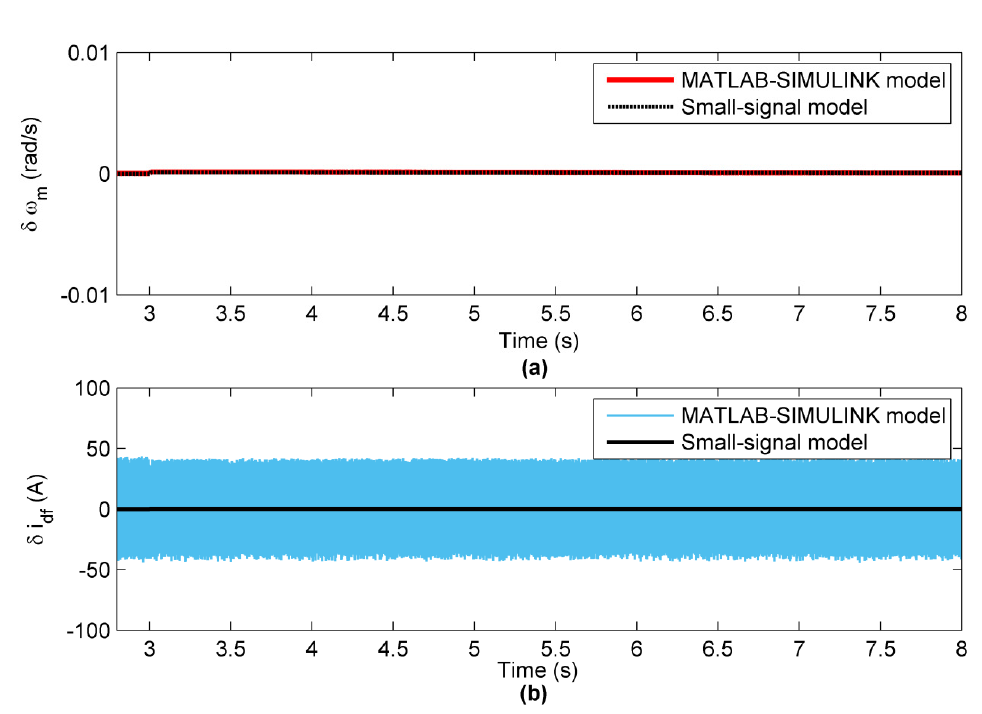
i δ ) in 30 V dc-link df